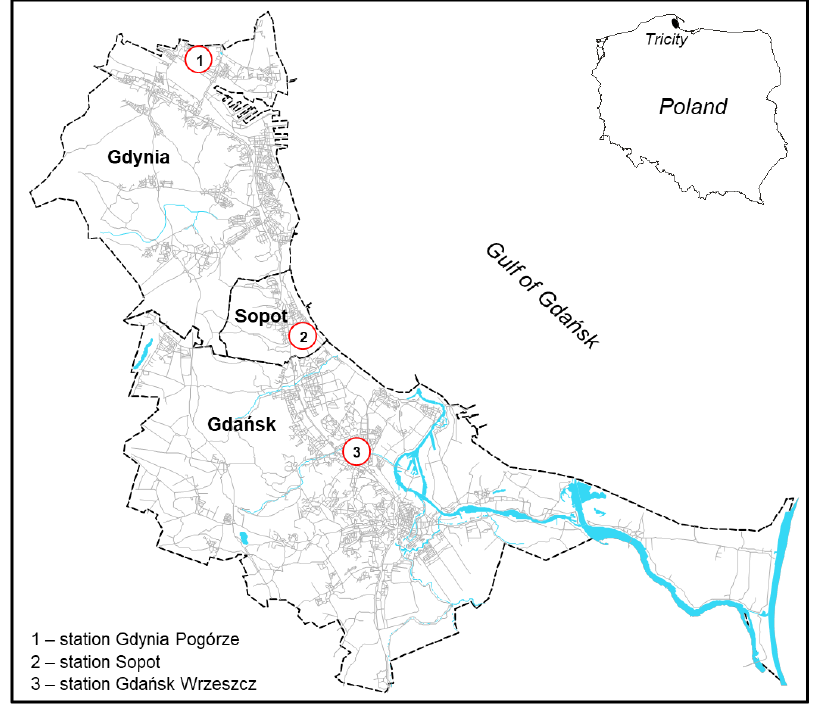
Figure 1. The location of the measuring stations in Agglomeration of Tricity (Poland).